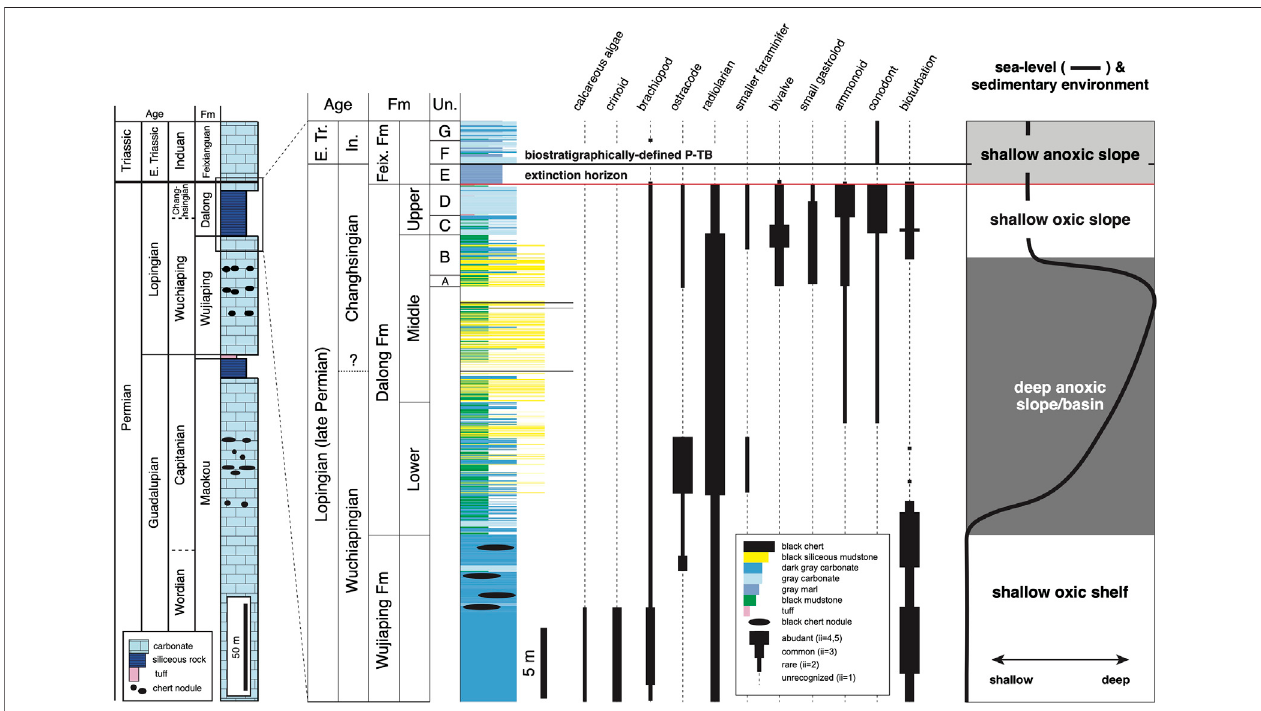
FIGURE 2 | The analyzed P-TB interval at Chaotian with ranges of fossil groups (modi fi ed from Saitoh et al., 2014a). Un.: unit in Isozaki et al. (2007), E. Tr.: Early Triassic, In.: Induan, Feix.: Feixianguan, ii: ichnofabric index.